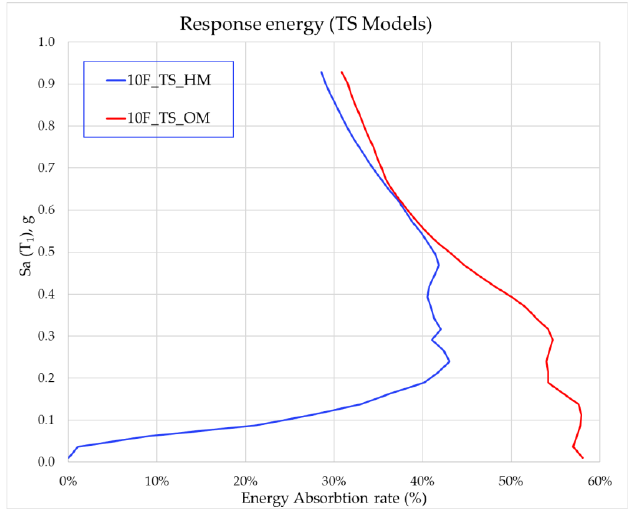
Figure 8. Energy response of hysteresis and oil dampers for TS models.